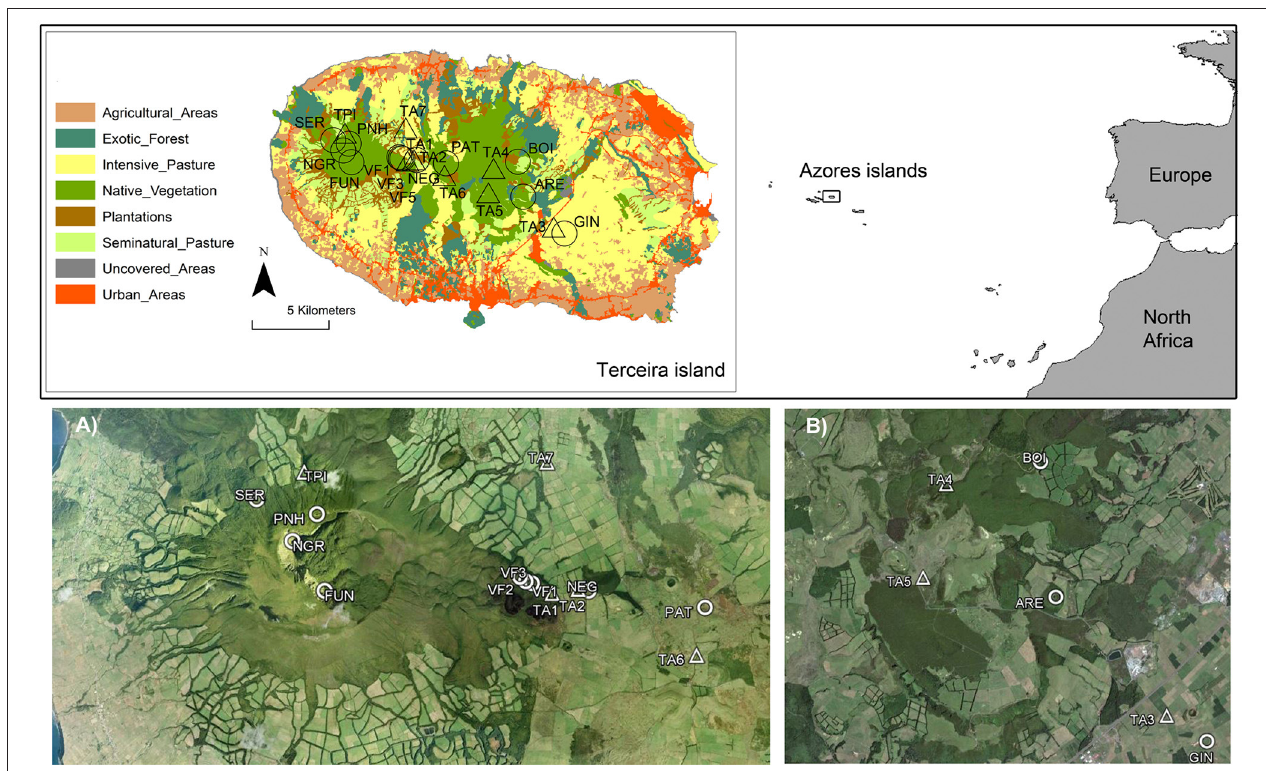
FIGURE 1 | Location of the Azores archipelago including Terceira Island (38 ◦ 40 ′ N − 27 ◦ 10 ′ W). The location of the study ponds and tanks are also shown in Terceira Island (ARE, BOI, FUN, GIN, NEG, NGR, PAT, PNH, SER, VF1, VF3, and VF5 are ponds; TPI, TA1, TA2, TA3, TA4, TA5, TA6, and TA7 are tanks). A land-use map for Terceira Island was included and divided into eight categories: (1) urban and industrial areas; (2) agricultural areas, including arable lands, fruit orchards and permanent crops; (3) exotic forests dominated mainly by Pittosporum undulatum ; (4) forestry plantations of Cryptomeria japonica and Eucalyptus spp.; (5) intensive managed pasturelands exposed to intensive cattle grazing throughout the whole year; (6) seminatural pasturelands, which were only managed with low cattle grazing activity and usually located in high elevation areas; (7) uncovered areas including rocky and open spaces without vegetation, and (8) native vegetation including native forests dominated by endemic plant species. At the bottom of the figure, we show a magnification of the location of natural ponds and artificial tanks embedded in (A) native vegetation, and (B) areas with some degree of